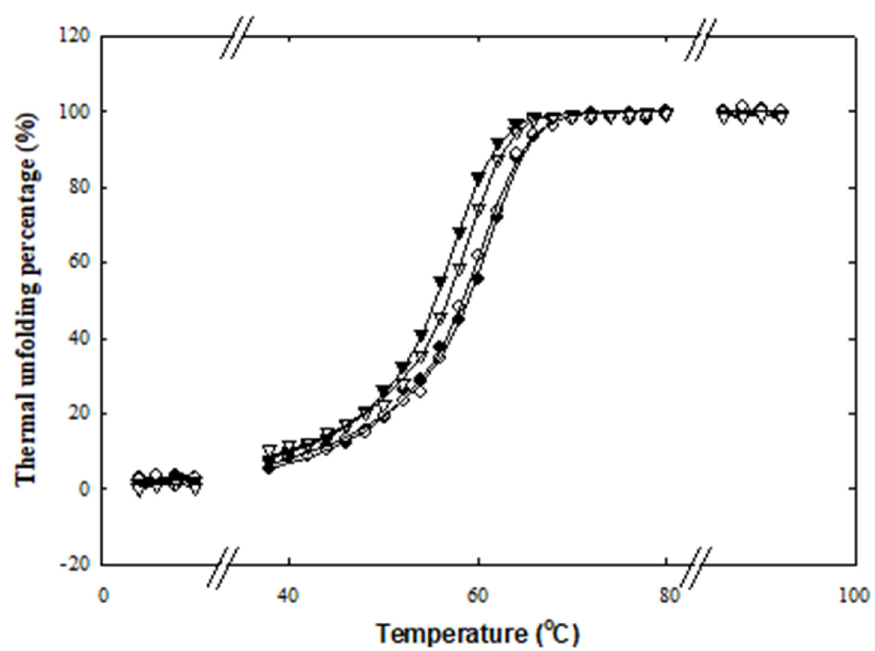
Figure 6. Thermal unfolding of HCV NS3 proteins recorded by far-UV CD spectroscopy. It was monitored by the change in ellipticity at a wavelength of 222 nm in the temperature range of 4–96 °C. The thermal denaturation (T m ) of fresh 37 °C produced ( ● ), fresh 25 °C produced ( ο ), long-term-stored 37 °C produced ( ▼ ), and long-term-stored 25 °C produced ( ∇ ) are obtained in order. Solid lines are the theoretical fitting curves with the thermodynamic parameters, also given in Table 2. Table 2. Thermodynamic parameters for unfolding transition of NS3 Proteins produced at 37 ◦ C and 25 ◦ C. 50%